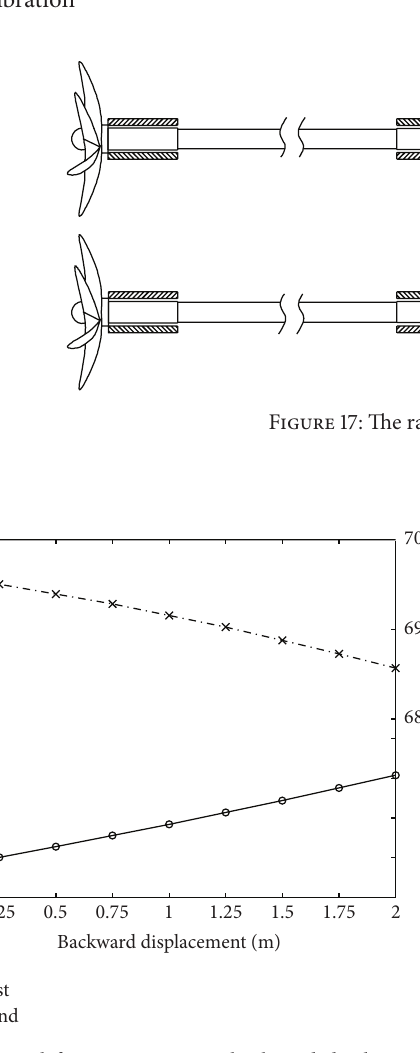
Figure 18: Natural frequencies versus backward displacement of thrust bearing.